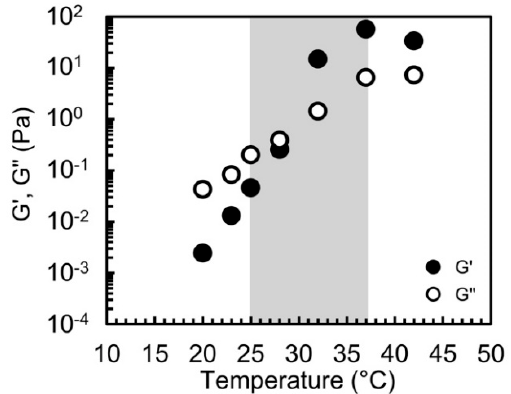
Figure 6. Storage and loss moduli G ’ and G ˝ as a function of temperature of the aqueous laponite/PEG1.0k–PLGA0.8k nanocomposites with the laponite concentration of 1.0 wt % and the PEG1.0k–PLGA0.8k concentration of 2.0 wt %.